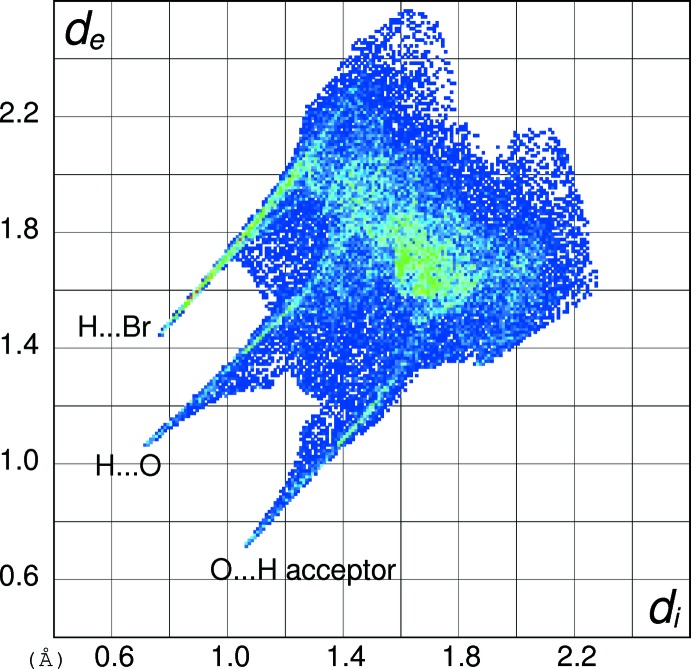
Hirshfeld fingerprint plot for the C7H9N2O2
+ cation in (II).